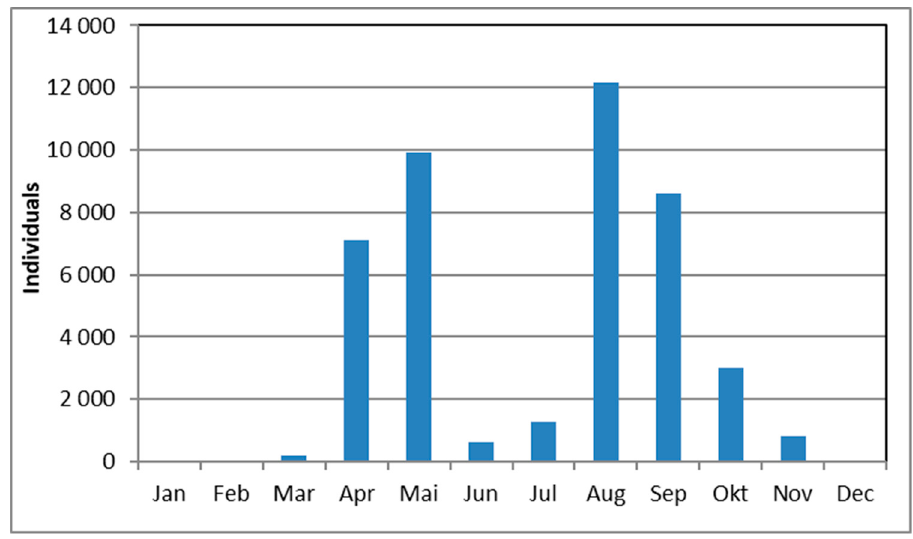
Figure 14. Chart of migrating fish, January–December, fish pass at HPP Schwabeck.